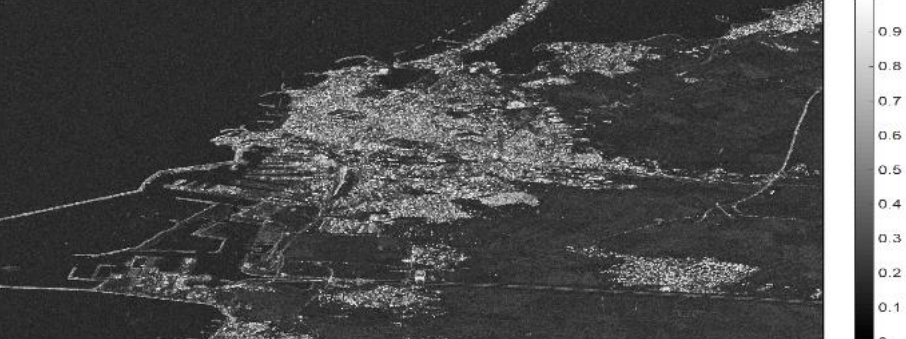
Figure 17. Spatial distribution of dataset’s correlation coefficient—Constanța region.